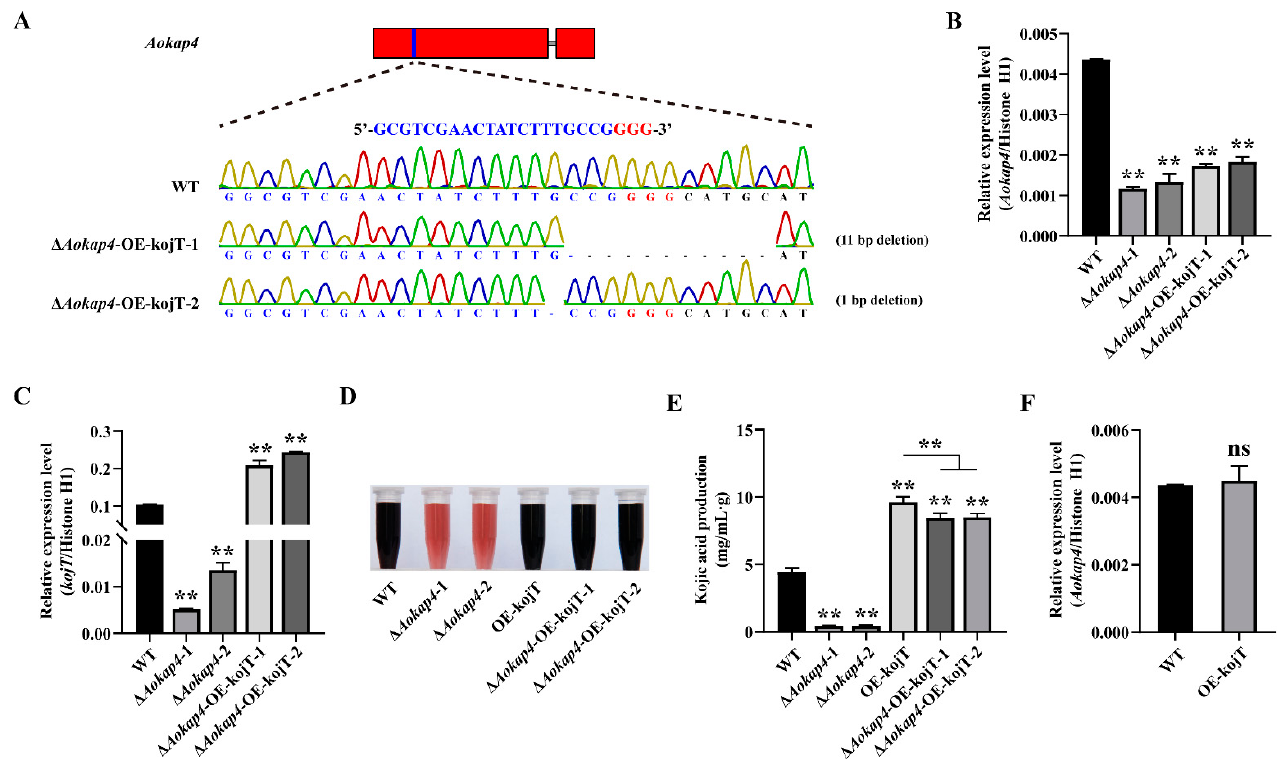
Figure 6. Overexpression of kojT in Aokap4- disrupted strain rescued the reduced production of kojic acid. ( A ) Targeted mutation of Aokap4 in the kojT -overexpression strain using the CRISPR/Cas9 system, producing the ∆ Aokap4 -OE-kojT strain where Aokap4 was deleted and kojT was overexpressed by A. oryzae amyB promoter. The targeted sequence of Aokap4 is indicated in blue and the PAM is shown in red. The mutation types and the numbers of mutated sequences are shown on the right. ( B , C ) Transcript levels of Aokap4 ( B ) and kojT ( C ) in the wild-type and ∆ Aokap4 -OE-kojT strains. ( D ) Color reaction of kojic acid with ferric ion, which is generated by WT, ∆ Aokap4 -1, ∆ Aokap4 -2, OE-kojT, ∆ Aokap4 -OE-kojT-1 and ∆ Aokap4 -OE-kojT-2. These strains were cultivated in the modified CD liquid medium for seven days. ( E ) The yield of kojic acid produced by WT, ∆ Aokap4 -1, ∆ Aokap4 -2, OE-kojT, ∆ Aokap4 -OE-kojT-1 and ∆ Aokap4 -OE-kojT-2 cultured in the modified CD liquid medium for seven days. ( F ) The expression level of Aokap4 in the wild-type and kojT- overexpression strains. Asterisks indicate statistically significant differences between the wild-type and mutants (** p < 0.01). ns, no significant difference.